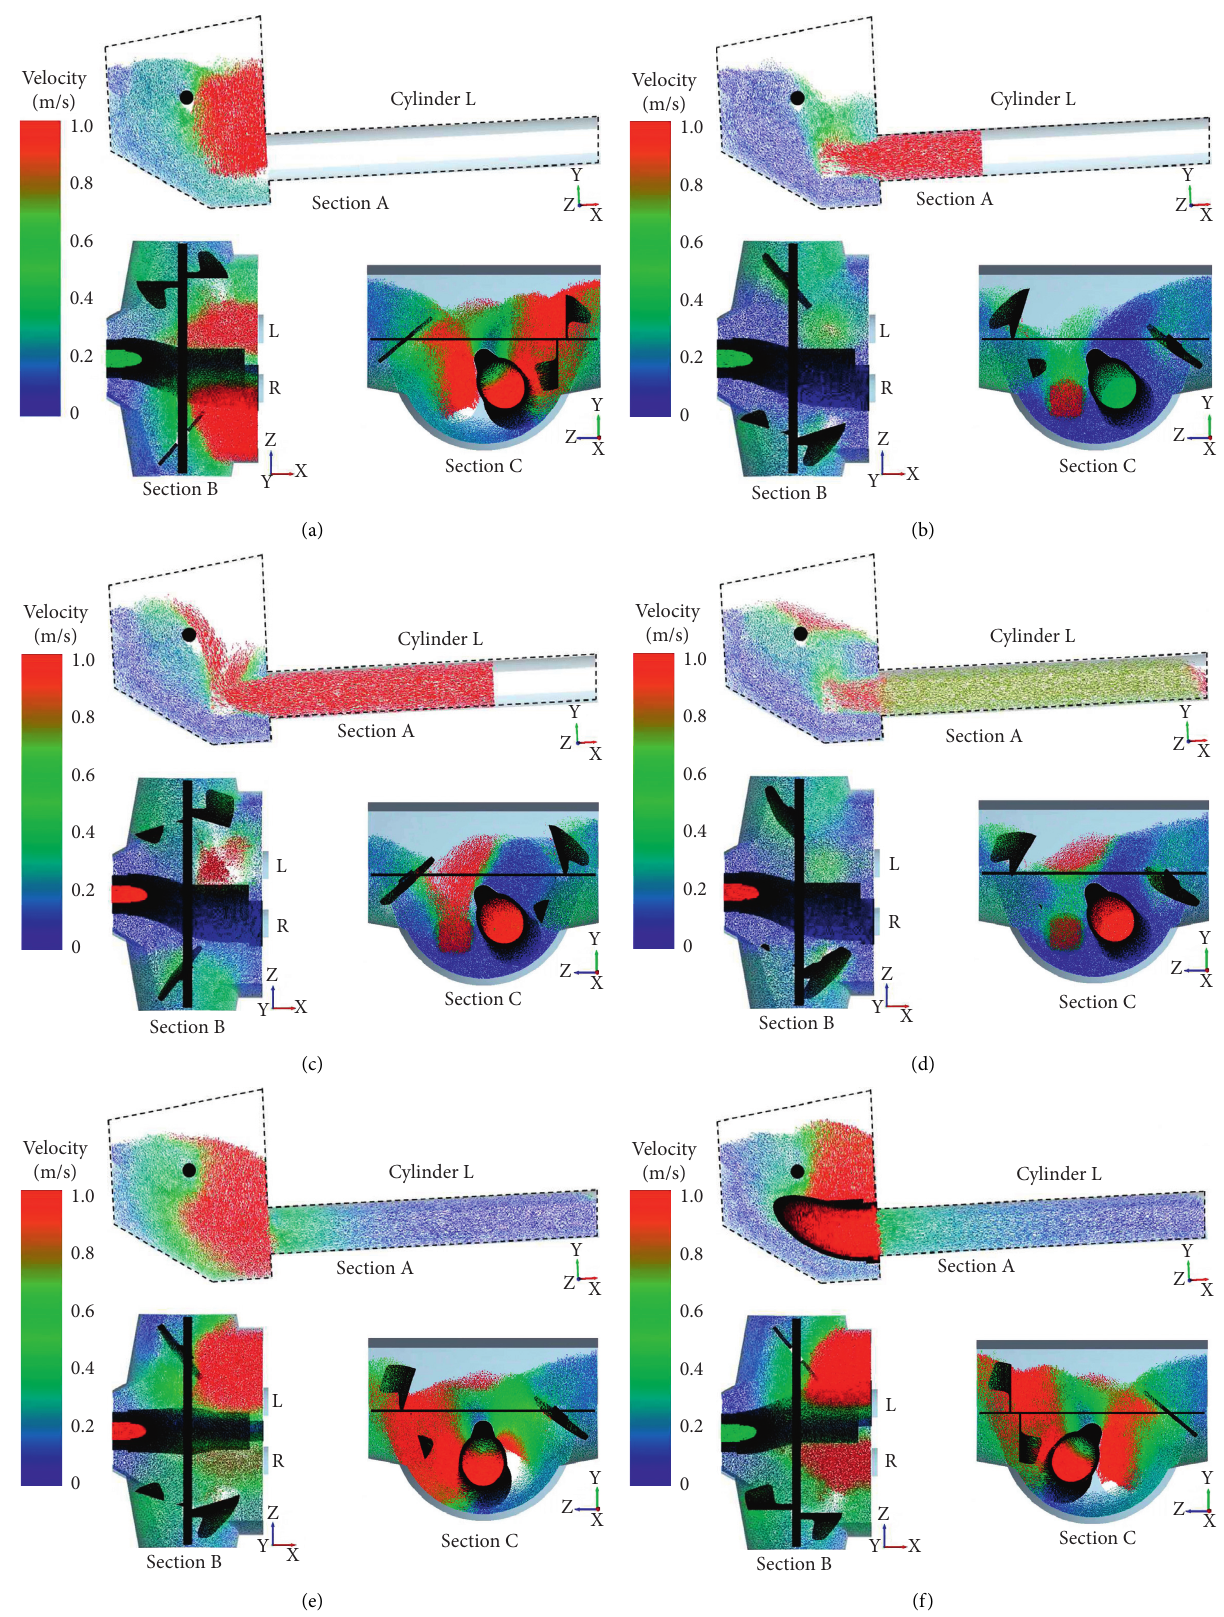
Figure 13: The concrete flow field of sections A, B, and C at different times: (a) t � 5.9s, (b) t � 6.4 s, (c) t � 7s, (d) t � 7.5 s, (e) t � 7.6 s, and (f) t �